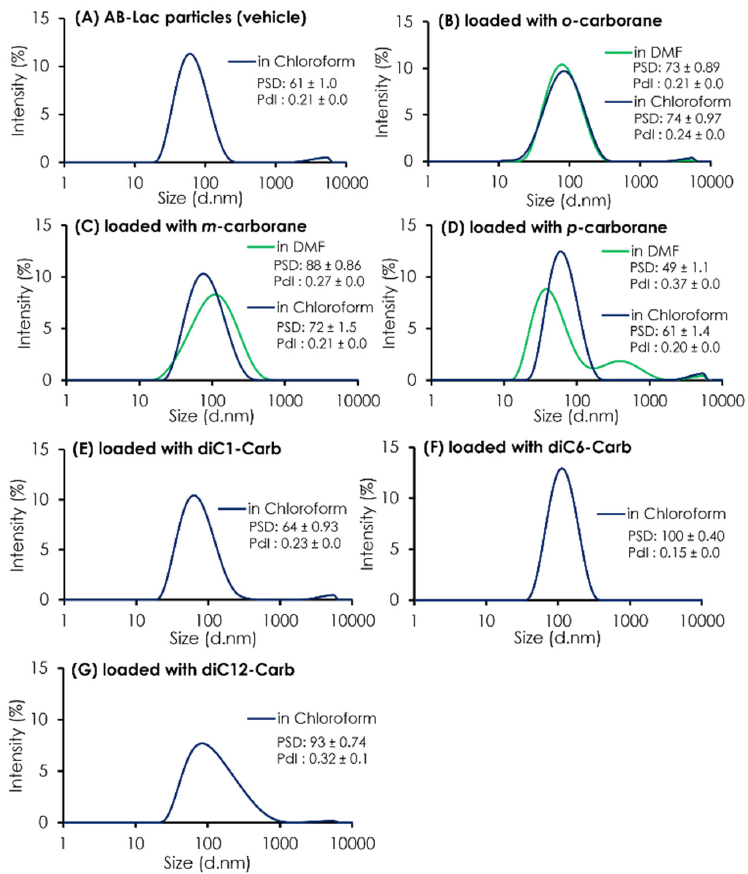
Figure 2. The PSD and PdI of AB-Lac particles loaded with a B compound. The AB-Lac particles (plain vehicles) ( A ), and those containing o -carborane ( B ), m- carborane ( C ), p- carborane ( D ), diC1-Carb ( E ), diC6-Carb ( F ), and diC12-Carb ( G ). The PSD and PdI are represented as mean ± S.D. ( n = 3).